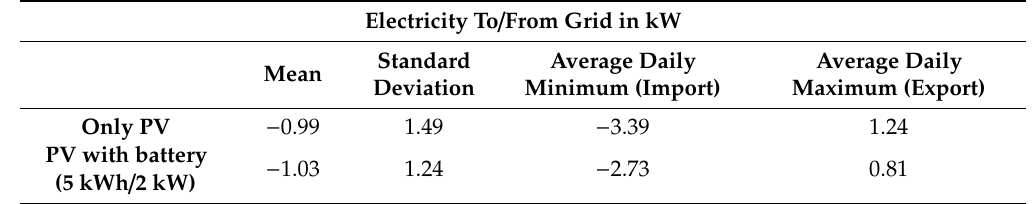
Figure 13. Number of excursions and ATP against battery capacity. Table 3. Electricity to / from grid in kW.